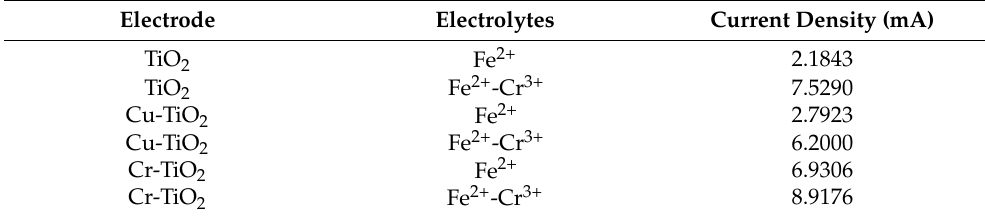
Table 2. Instantaneous current plot of metal ion-doped TiO 2 electrode in different electrolytes (120–240 s).